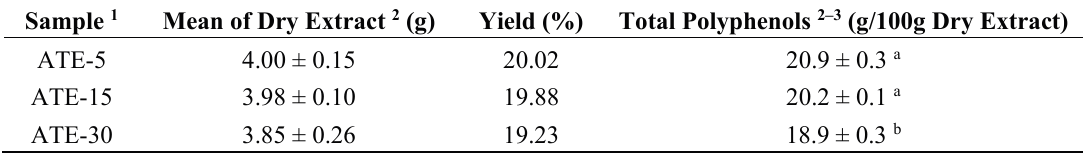
Table 1. Yield percent and total polyphenols of aqueous tea extracts.